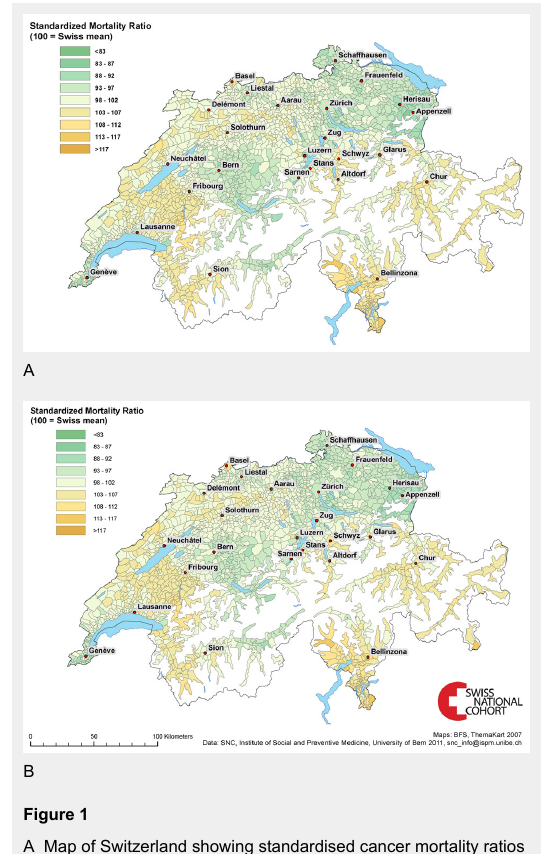
Figure 1 A Map of Switzerland showing standardised cancer mortality ratios for older Swiss men (≥65 years old). B Map of Switzerland showing standardised cancer mortality ratios for older Swiss women (≥65 years old). © BFS. Reprinted with permission.